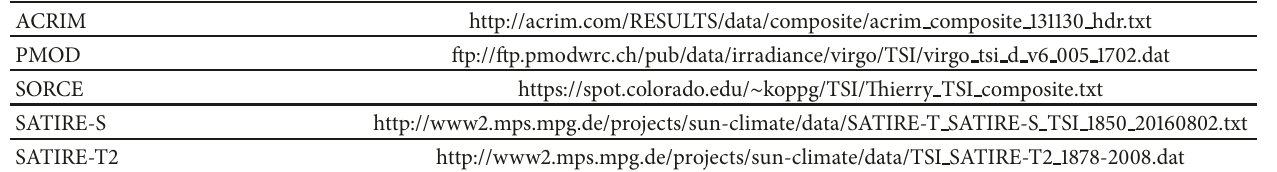
Table 3: The TSI composite